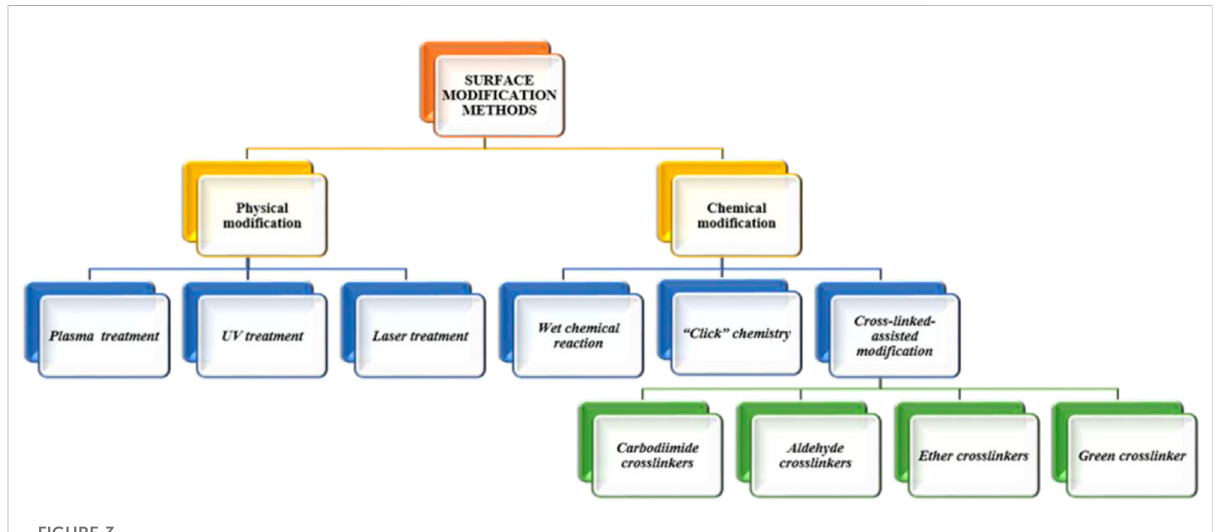
FIGURE 3 Schematic representation of several techniques for surface modi fi